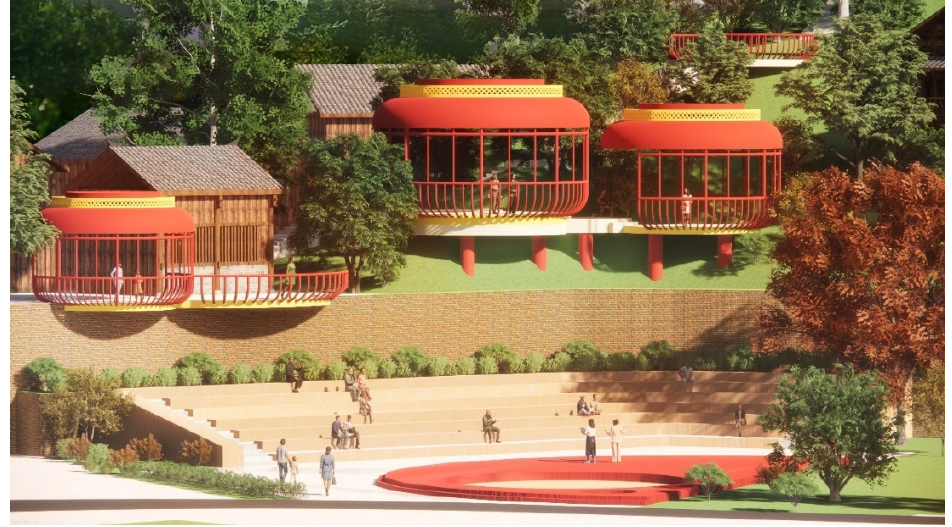
Figure 17. Outdoor performance